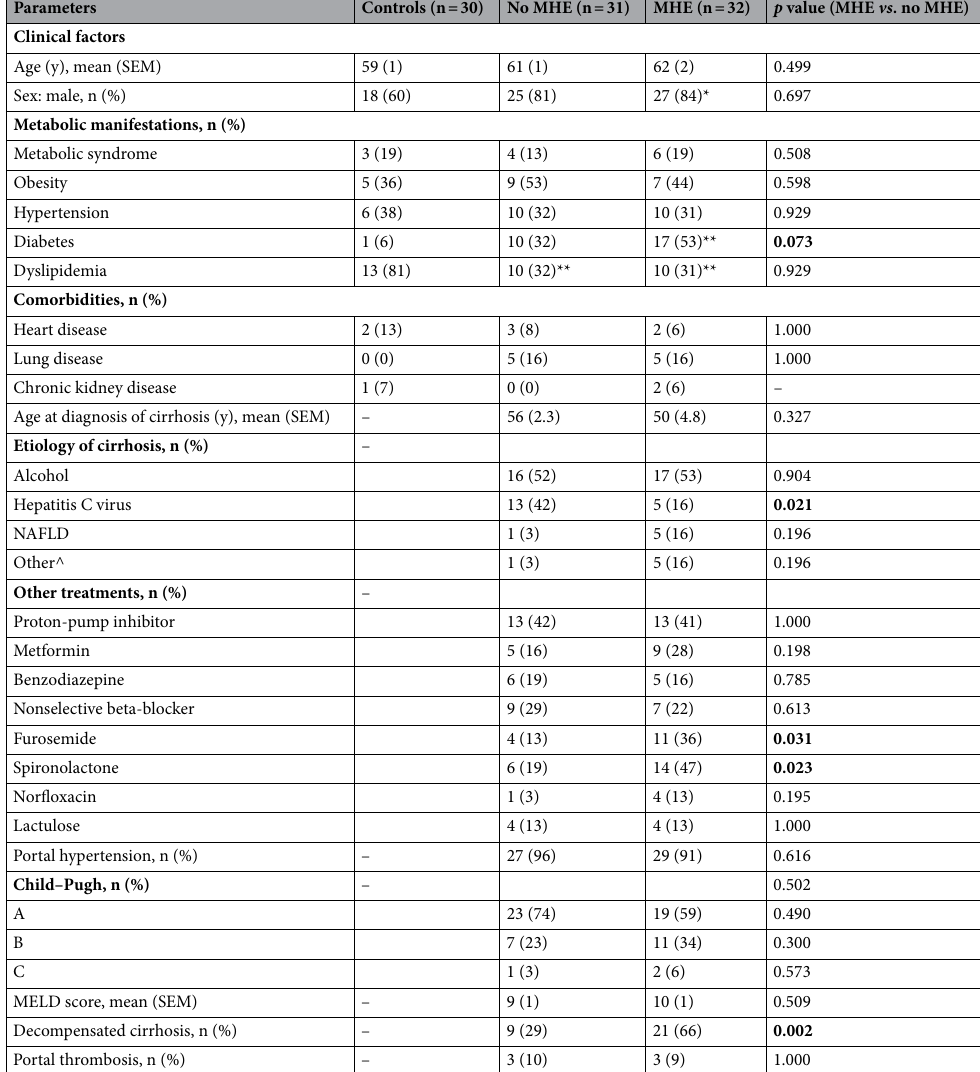
Table 1. Baseline characteristics of the study population. ^ Hepatitis B virus, primary biliary cholangitis, autoimmune, hemochromatosis or cryptogenic cirrhosis. All biochemical values are expressed as mean the mean; M/F: male/female; NAFLD: non-alcoholic fatty liver disease. Significance values are